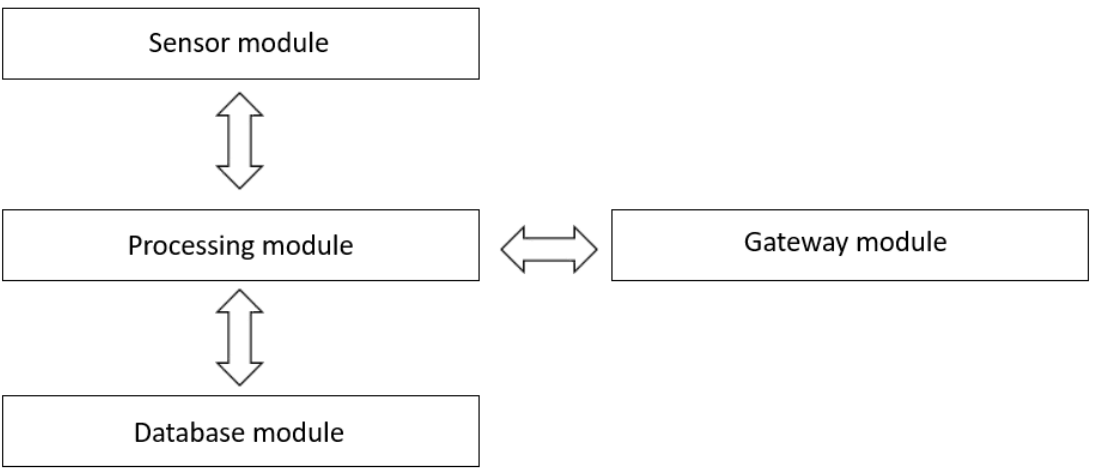
Figure 5. Client application system